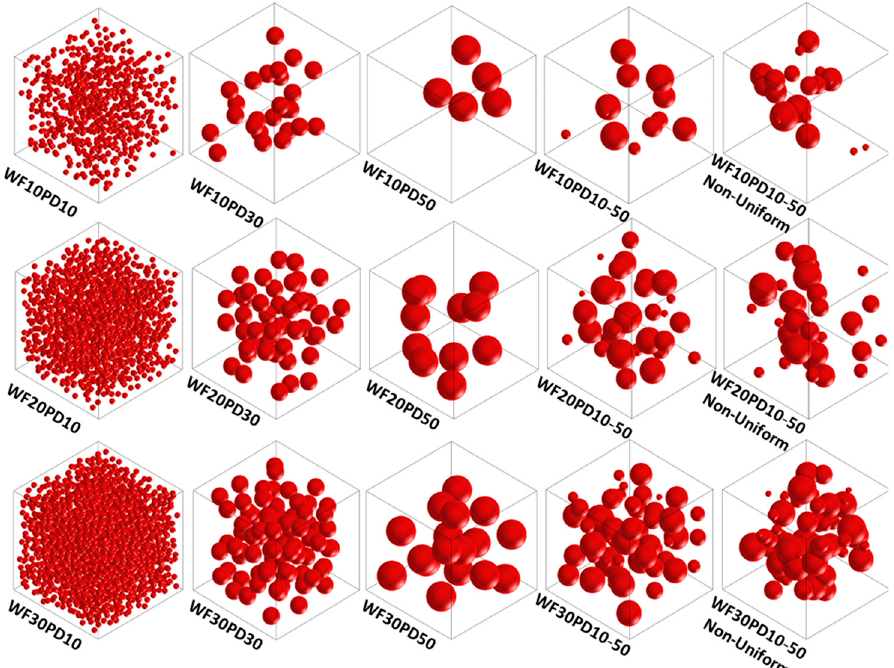
Figure 3. Micromodel of composites with differing composition proportions (WTx), particle diameters (PDx) and dispersibilities (uniform distribution by default, non-uniform distribution is marked).